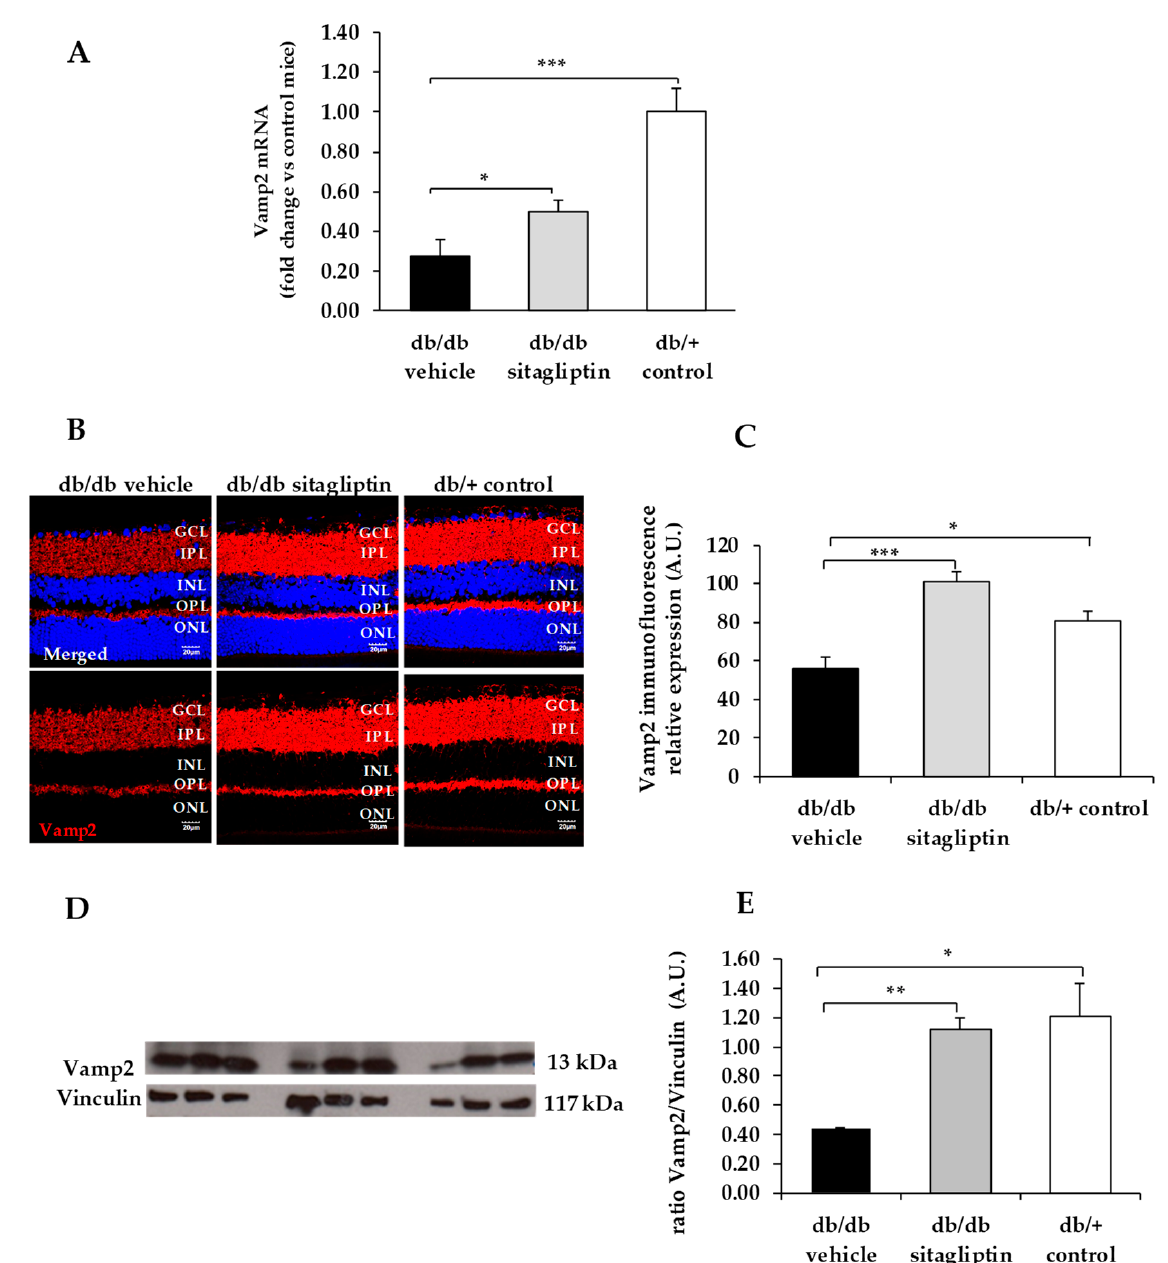
Figure 5. ( A ) Real-time quantitative RT-PCR analysis of VAMP2 gene (Vamp2) in db/db mice treated with vehicle (black bars), sitagliptin eye drops (grey bars), and in non-diabetic mice (white bars). ( B ) Immunofluorescence of VAMP2 (red) among representative samples of diabetic retinas of experimental groups. Hoechst staining (blue) was used for nuclei labeling. ONL: outer nuclear layer; OPL: outer plexifom layer; INL: inner nuclear layer; IPL: inner plexiform layer; GCL: ganglion cell layer. Scale bars, 20 µ m. ( C ) Quantification of VAMP2 immunofluoresence in diabetic mice treated with vehicle eye drops (black bars), sitagliptin eye drops (grey bars), and in non-diabetic retinas (white bars). ( D ) Western blot bands of VAMP2 and ( E ) Densitometric analysis in db/db mice treated with vehicle eye drops (black bars), sitagliptin eye drops (grey bars), and in non-diabetic mice retinas (white bars). Protein levels were normalized with vinculin. * p < 0.05, ** p < 0.01, *** p < 0.001.